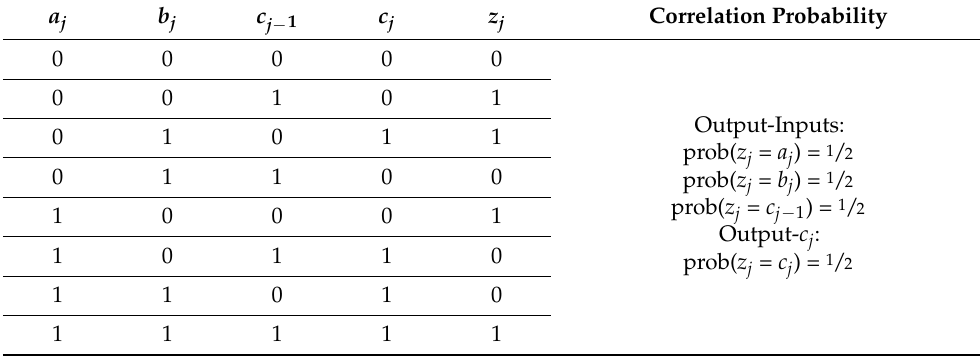
Table 6. Correlation probability of DSG.